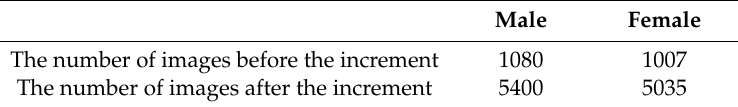
Figure 5. CIA dataset. Table 11. The number of images before and after the increment in CIA.